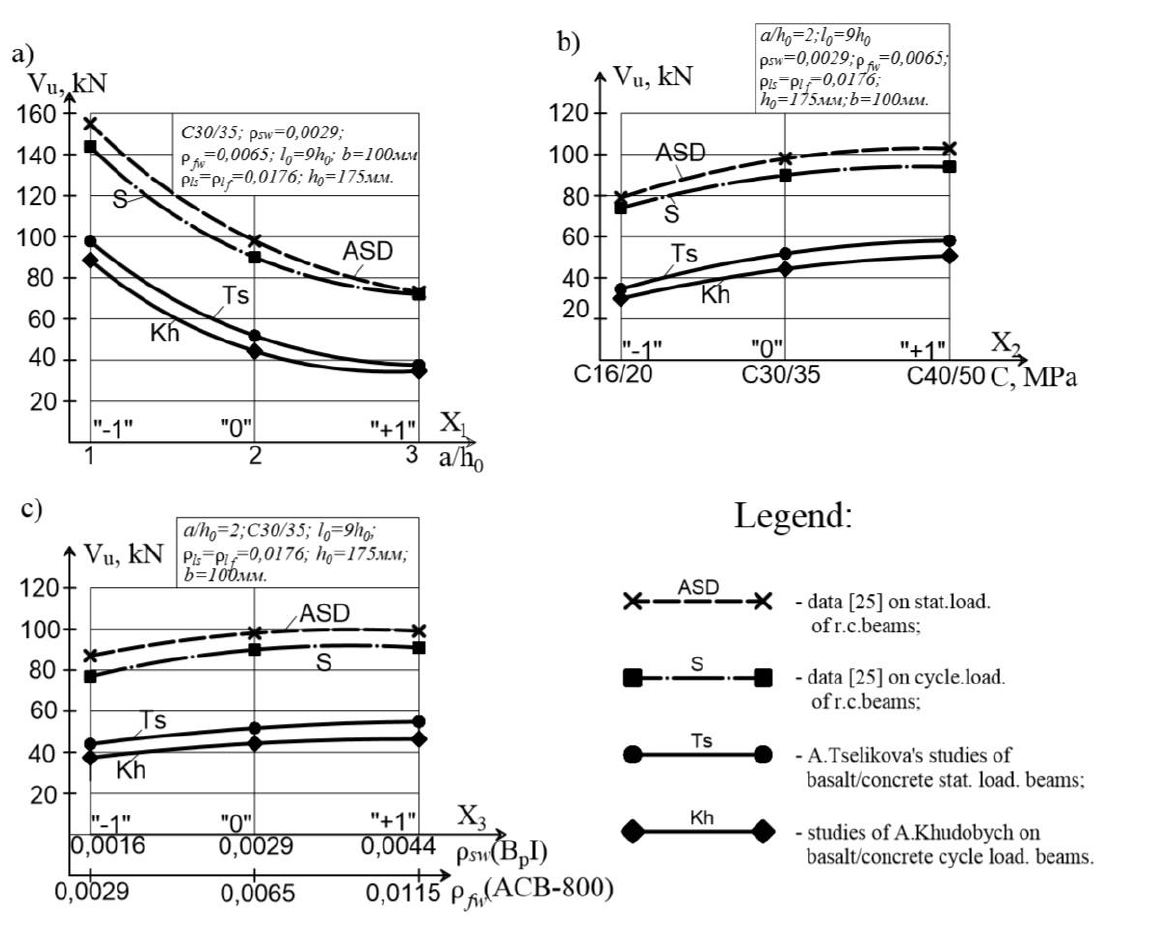
Figure 1. Impact of the relative shear span (a), concrete grade (b) and quantity of the transverse reinforcement (c) on the load-bearing capacity of the test element support